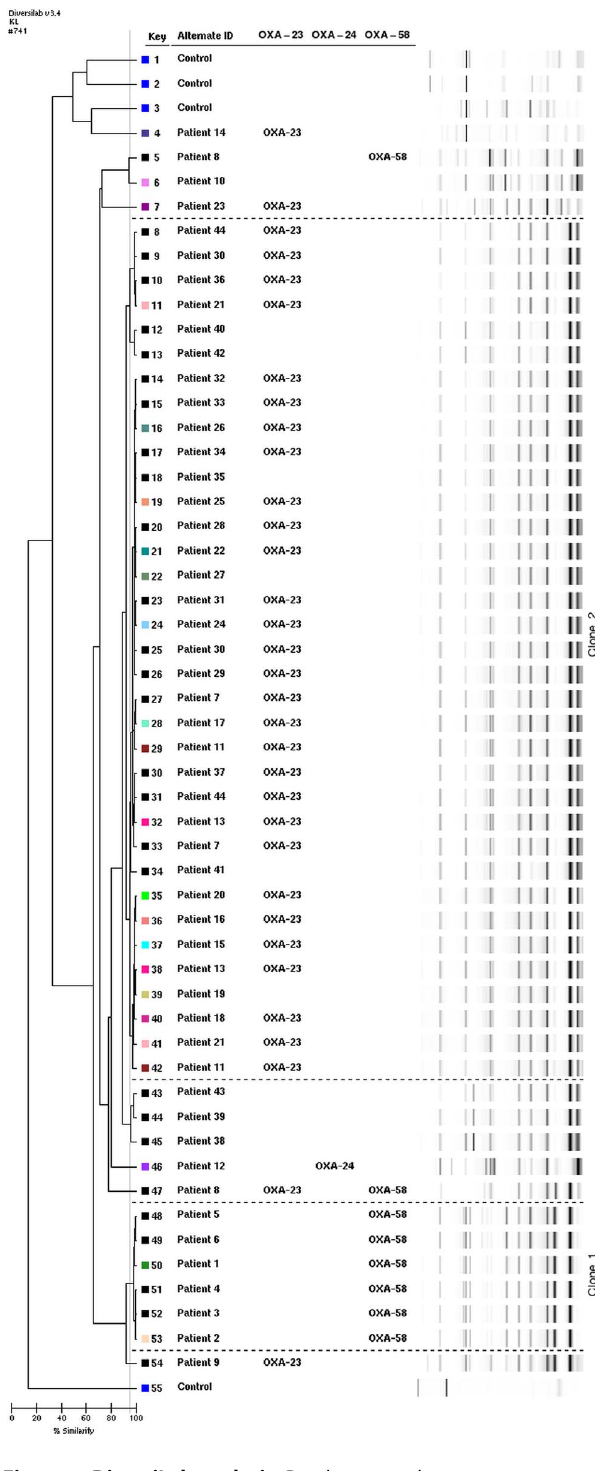
Figure 1. DiversiLab analysis. Dendogram and computer-generated image of rep-PCR banding patterns showing clustering between oxacillinase genes; OXA-23-like, OXA-24-like and OXA-58.